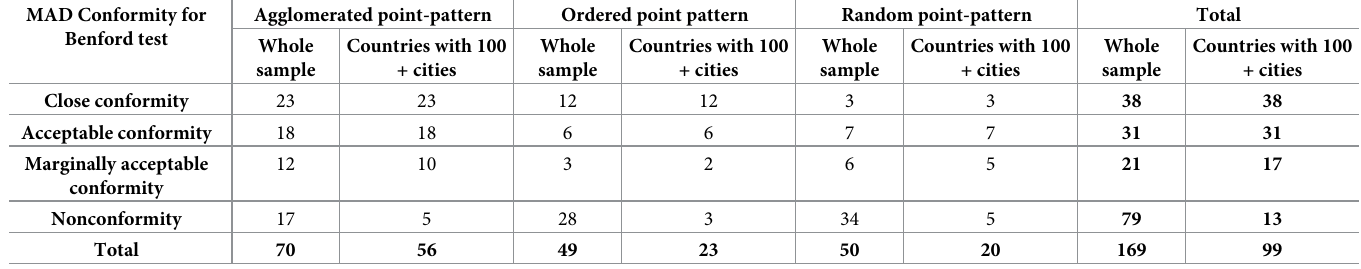
Table 2. Relation between Benford and spatial 2D distributions.